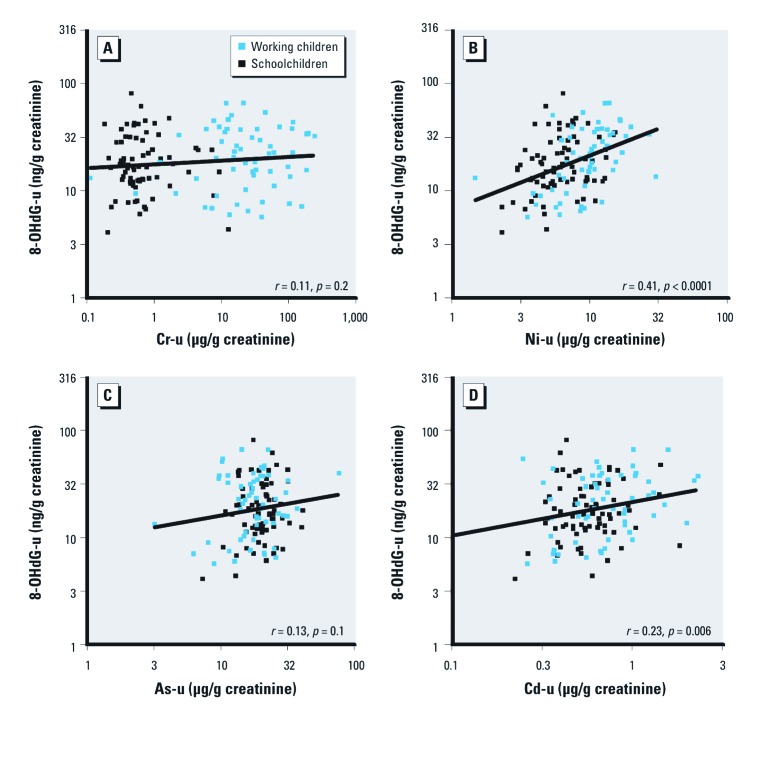
Association of 8-OHdG in urine with urinary (-u) concentrations of Cr (A), Ni (B), As (C), and Cd (D). Both axes are logarithmically scaled. The data points are the individual actual values.